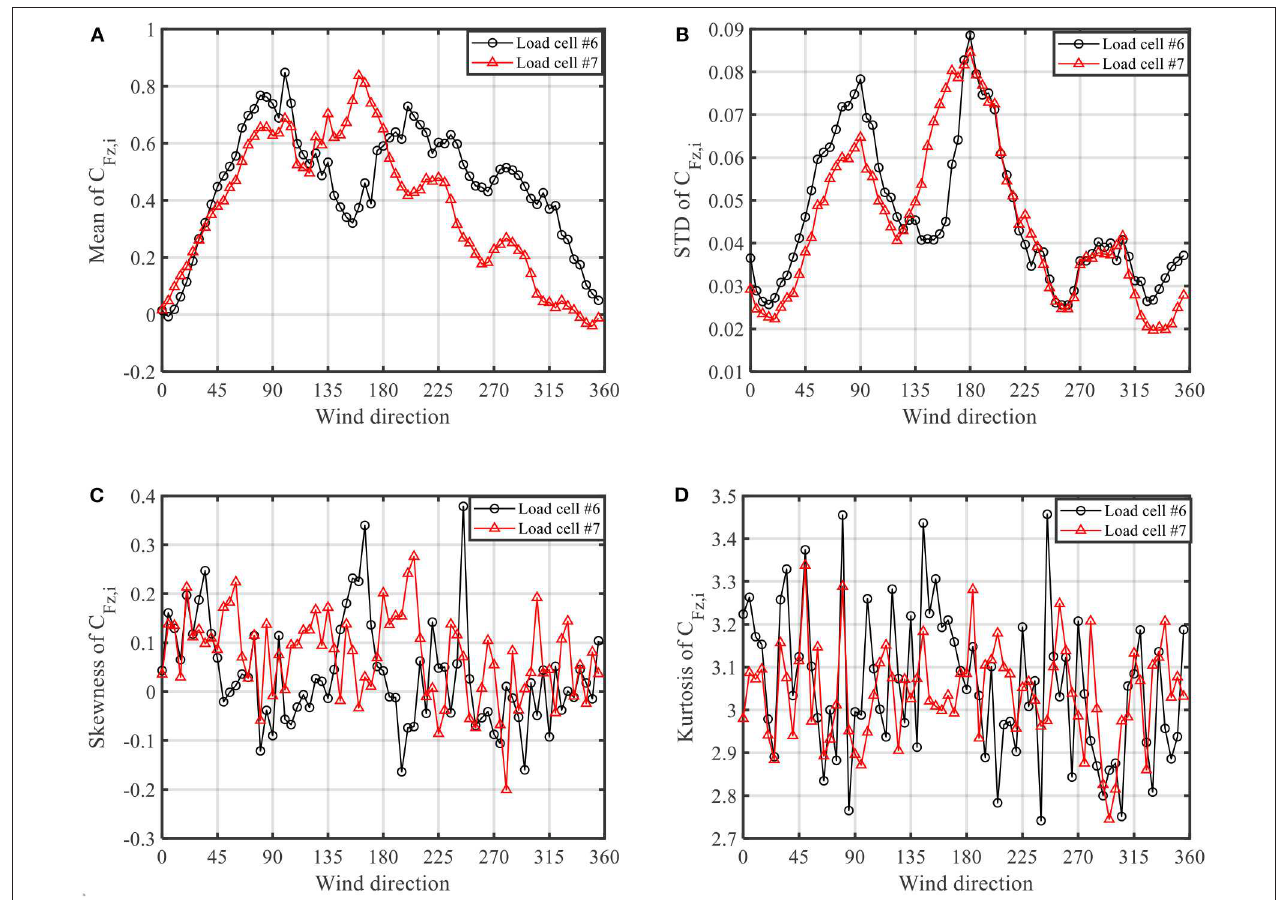
FIGURE 10 | Statistical moments of RTWC force coefficients (fully enclosed building). (A) Mean. (B) STD. (C) Skewness. (D) Kurtosis.